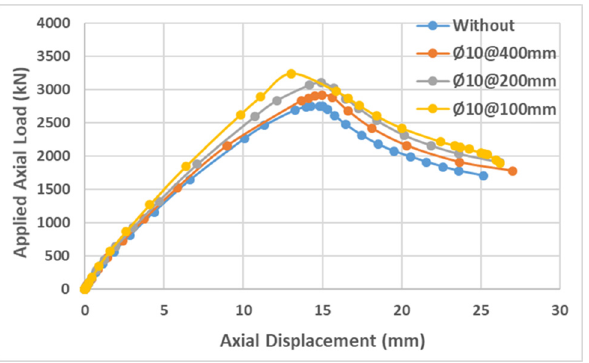
Figure 12: E ff ect of duration of exposing fi re on load - vertical dis - placement behavior for